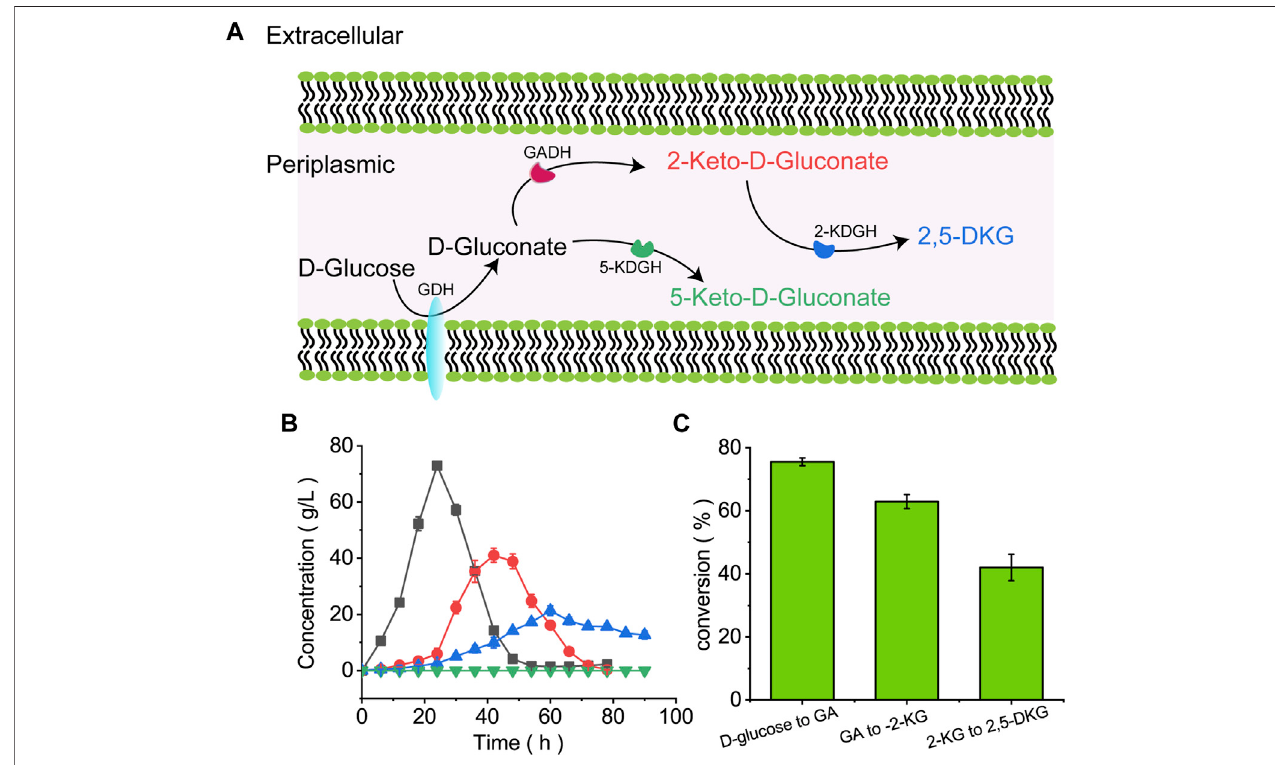
FIGURE 2 | The microbial pathway showing D-glucose conversion to 2,5-DKG. (A) D-Glucose conversion to 2,5-DKG in the periplasmic space; (B) Consumption andformationofD-gluconicacid,2-KG,2,5-DKG,and5-KGby G.oxydans ATCC9937.Black=D-gluconicacidlevels;red=2-KGlevels;blue=2,5-DKGlevels;green = 5-KG levels. (C) Illusion rate of various